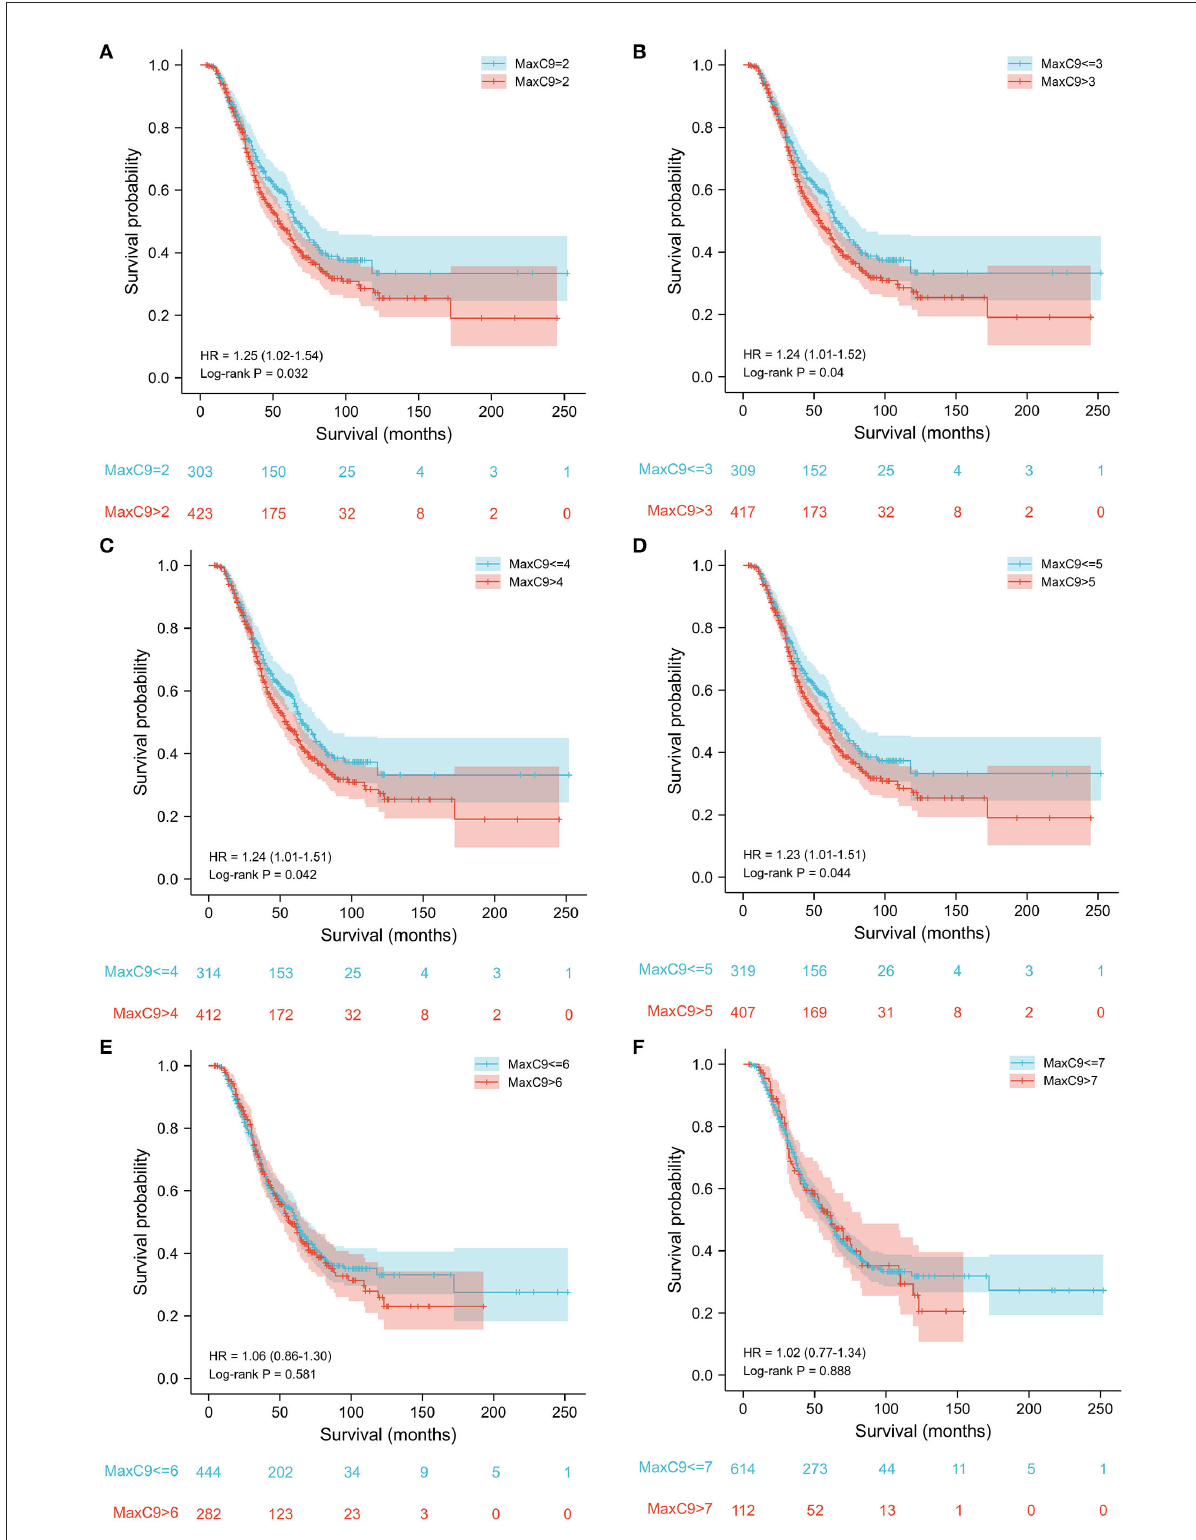
FIGURE3 Survival analysis of patients without C9orf72 HRE using a series of cutoff values of GGGGCC repeat length from 2 to 7. Cutoff values of 2–5 (A–D) could discriminate the survival difference, while cutoff values of 6 and 7 (E,F) could